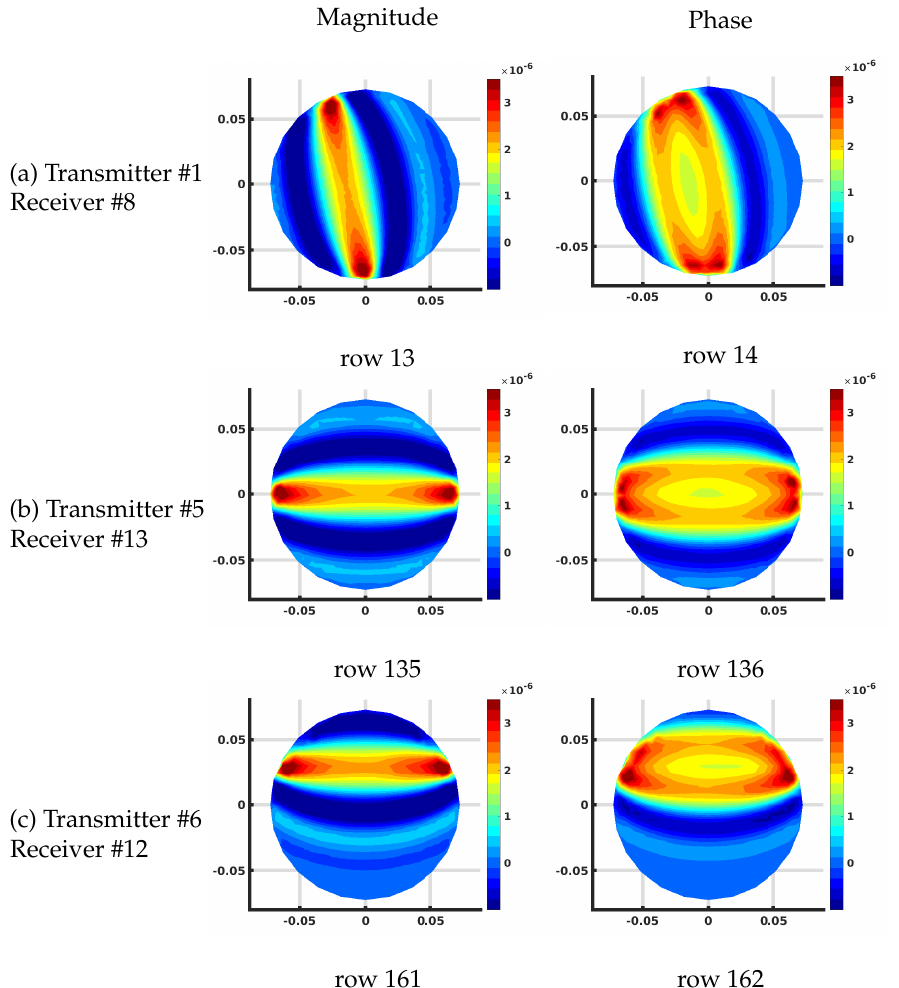
Figure 8. Plots of the effective log magnitude ( left ) and phase ( right ) distributions for various rows of Jacobian matrix (m 2 ), corresponding to multiple transmitter/receiver pairs, for the finite element (FE)-based algorithm. The distributions are presented on the coarse FE-mesh. Other than this scaling factor, the results are essentially